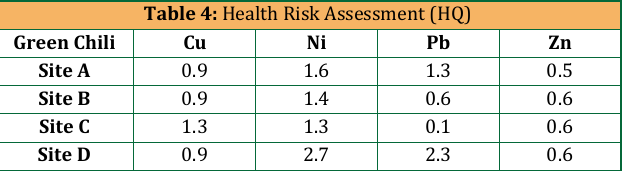
Table 4: Health Risk Assessment (HQ)